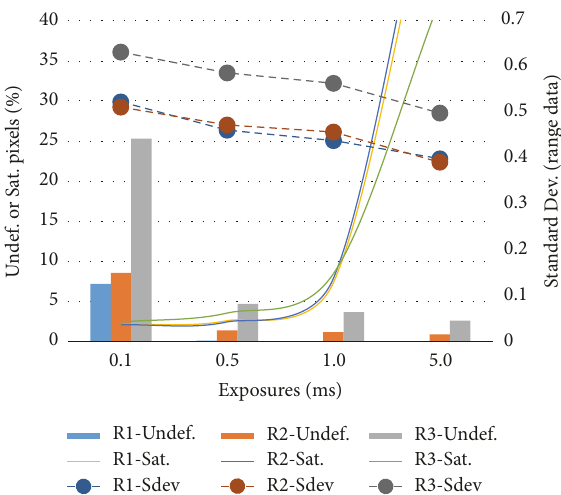
Figure 16: Quality parameters versus exposure times.